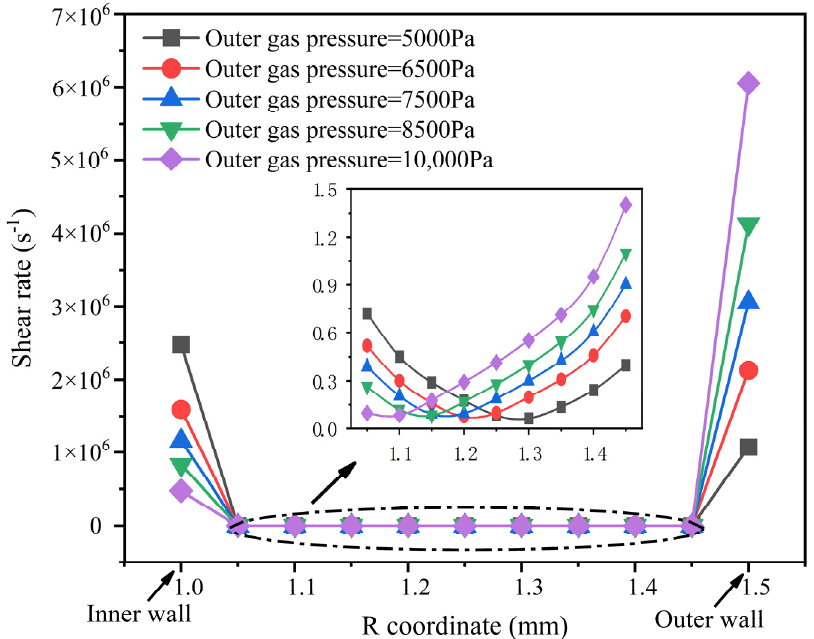
Figure 8. The distribution of melt shear rate field under different pressure of the outer gas cushion layer.